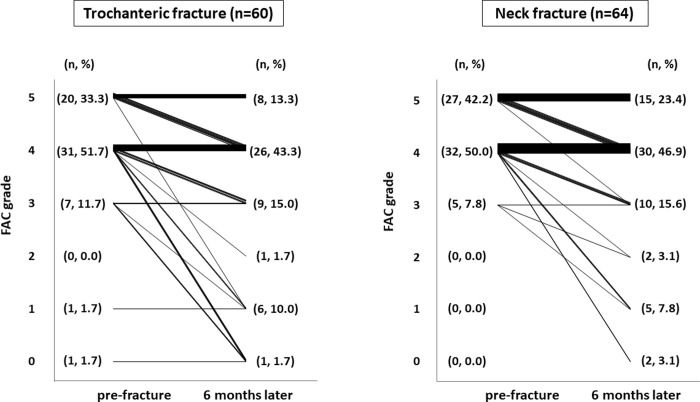
FAC score before fracture and 6 months later.The FAC score before fracture is shown on the left side of each graph, and the FAC score after 6 months is shown on the right side. The two scores are connected by a line, and the thickness of the line corresponds to the number of patients.